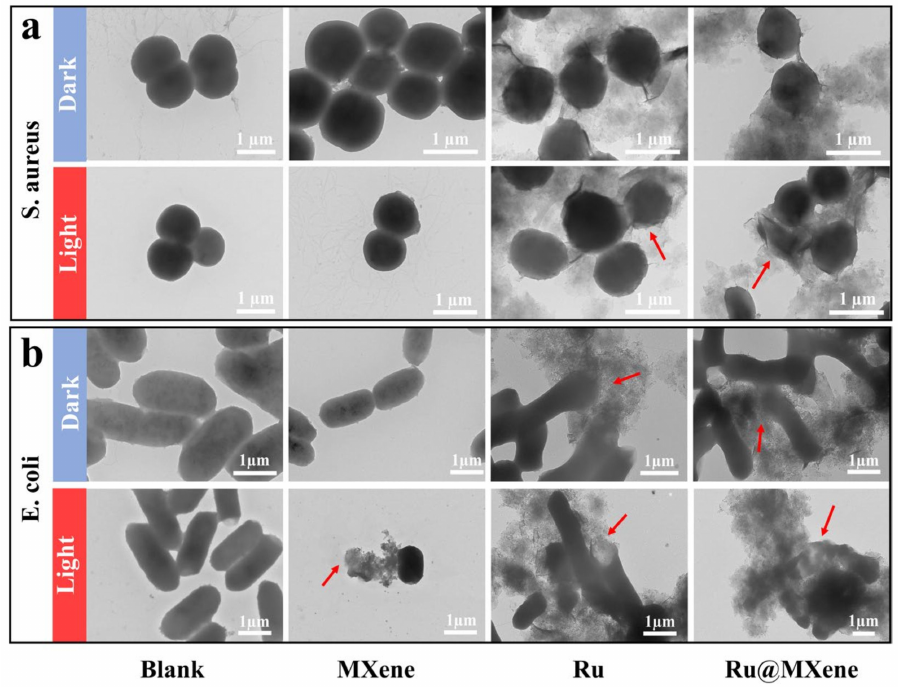
Figure 9. TEM images of bacterial structure and morphology of ( a ) S. aureus and ( b ) E. coli after being treated with MXene, Ru and Ru@MXene under dark or illumination. (xenon lamp, 150 mW/cm 2 , 30 min). Red arrows: disrupted bacterial